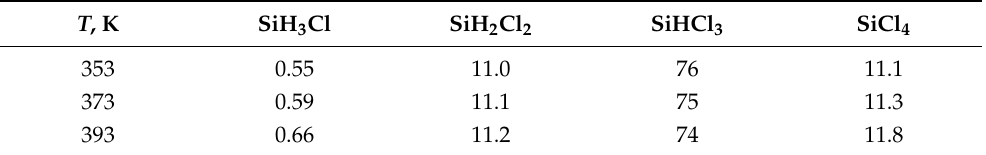
Table 1. The composition of the products of the TS dismutation reaction under static conditions after one hour of the TS in the reactor (molar percentages).